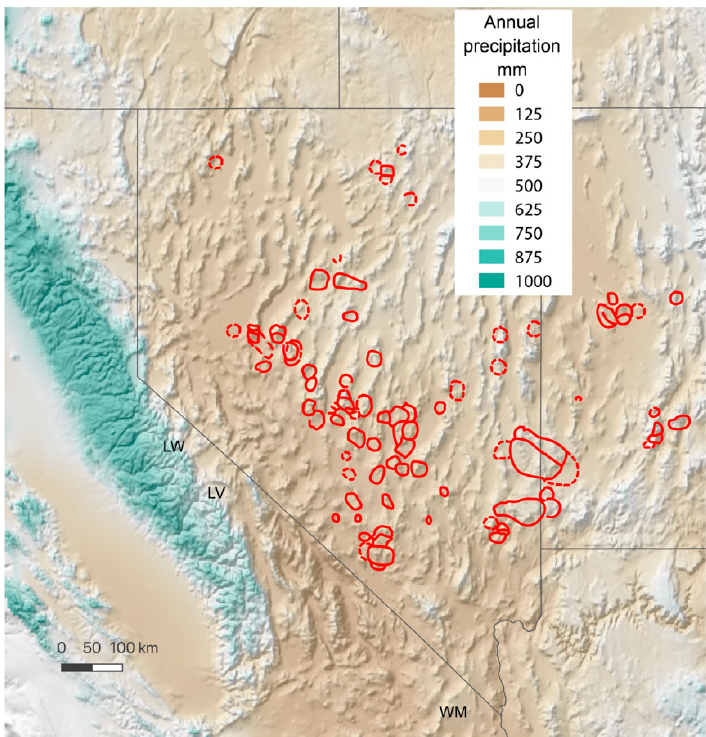
Figure 6. Map of Nevada and surroundings, showing calderas from Henry and John [70] and mean annual precipitation. The ignimbrite flareup started at ~45 Ma in Idaho and swept south and southwest to southern Nevada ~15 Ma, but the voluminous caldera-forming events stopped as they approached the California border, perhaps fearful of high taxes or that their fruit would be confiscated. One explanation for this western border is that caldera-forming eruptions were favored in the arid high plateau of Nevada but suppressed in wetter regions closer to the ocean. LW, LV, and WM refer to Little Walker, Long Valley, and Woods Mountains